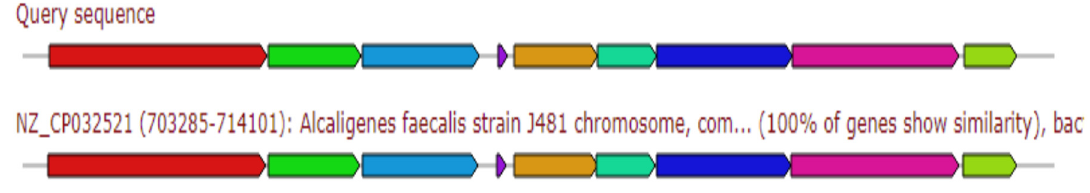
Figure 4. Gene arrangement of bacteriocin gene cluster homologous to query sequence of A. faecalis isolate MZ921504. Putative biosynthetic genes presented in red, additional biosynthetic genes in orange, transport-related genes in blue, regulation-related genes in green color, resistance genes in pink, TTA codon in dark pink and grey represent other genes.